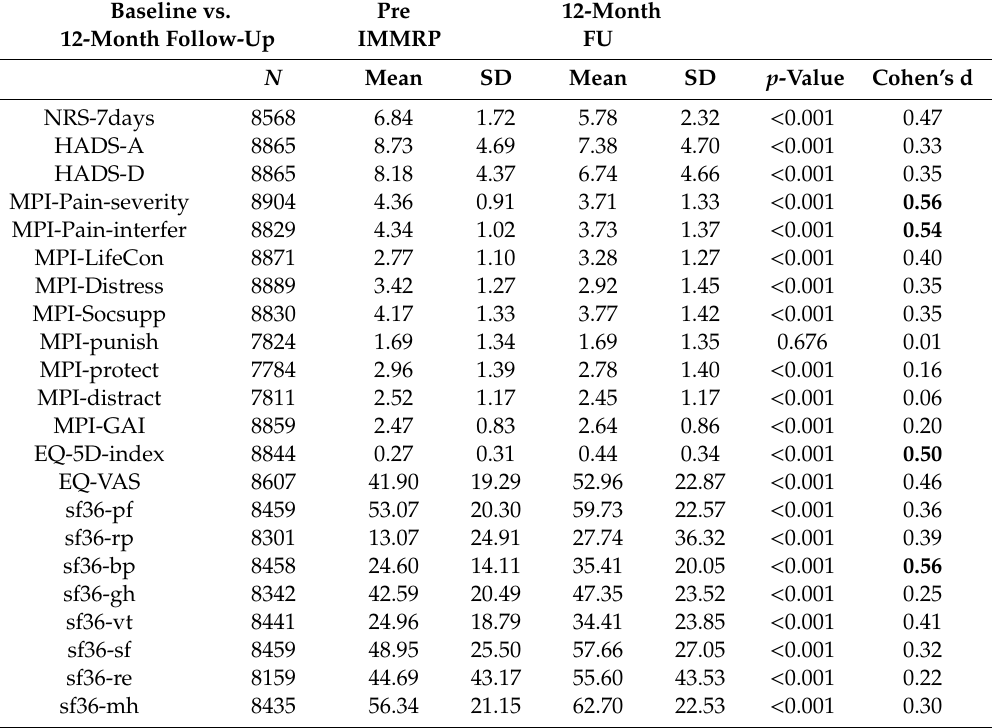
Table 3. Outcome variables at baseline (pre-IMMRP) and at the 12-month follow-up (FU). Statistical comparisons are presented furthest to the right together with e ff ects sizes (i.e., Cohen’s d). E ff ect sizes in bold were moderate (i.e., Cohen’s d ≥